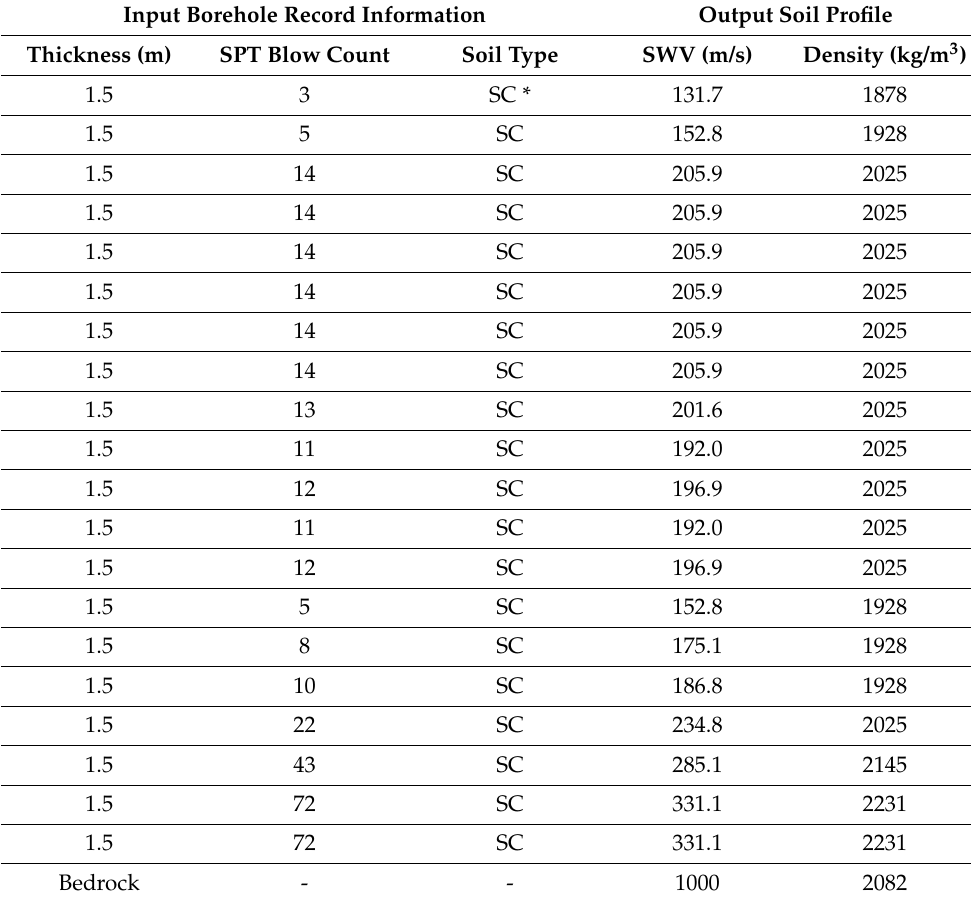
Table A1. Characteristics of soil column obtained from the retrieved borehole